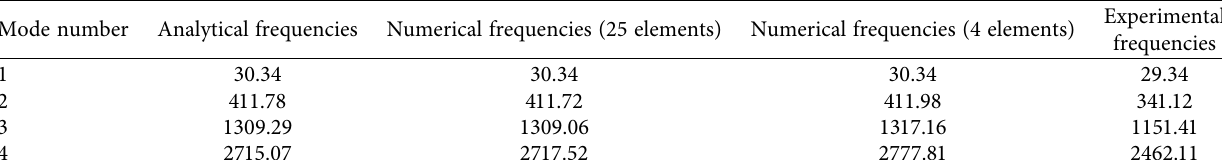
Table 2: First four natural frequencies (rad/s) with analytical, numerical, and experimental methods.